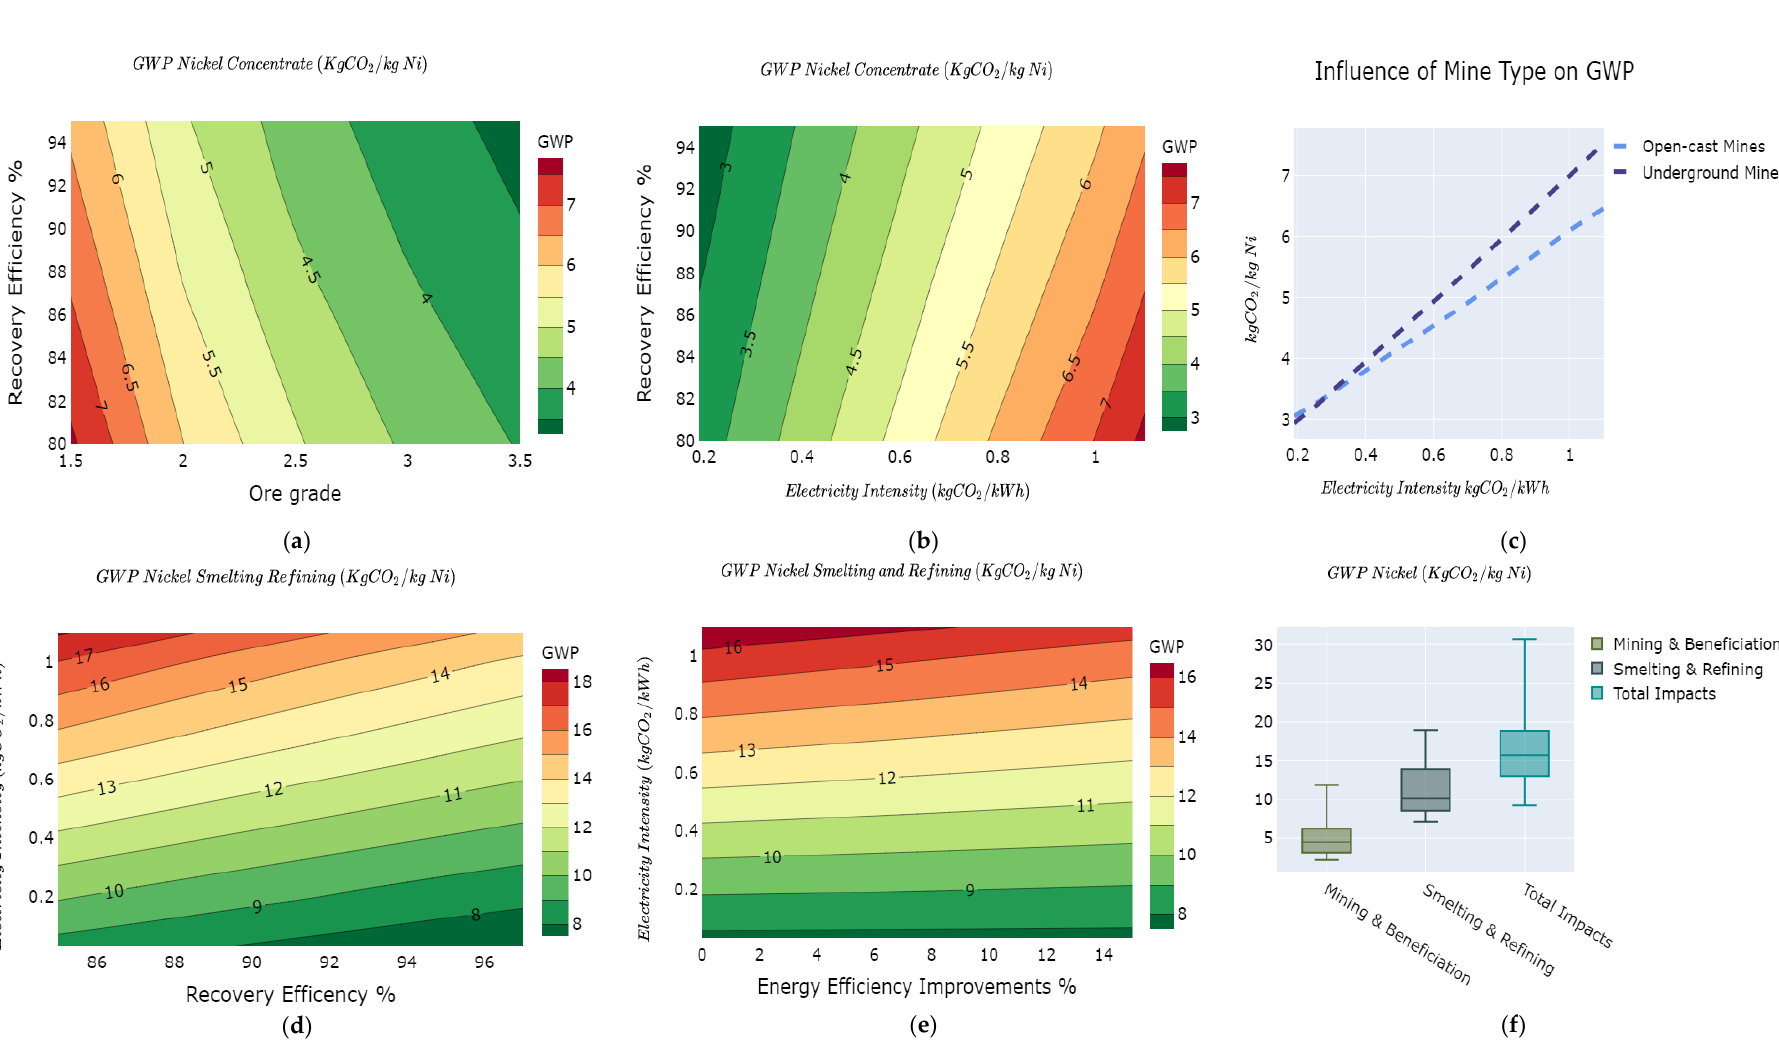
Figure 7. GWP variability of the nickel value chain as a function of ( a ) ore grade vs. recovery efficiency for mining and concentration; ( b ) electricity mix intensity vs. recovery efficiency for mining and concentration; ( c ) electricity mix intensity vs. mine type; ( d ) smelting/refining recovery efficiency vs. electricity mix intensity; ( e ) energy efficiency improvements vs. electricity mix intensity; and ( f ) overall GWP variations nickel value chain.